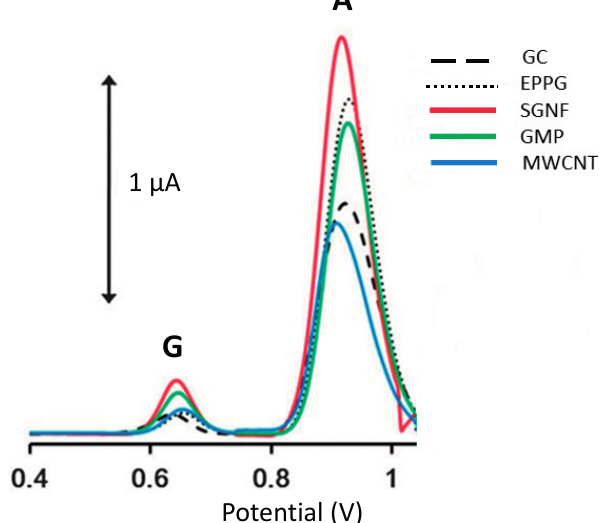
Figure 2. DPV of Gua (G) and Ade (A) on glassy carbon (GC), edge plane pyrolytic graphite (EPPG), stacked graphene nanofibers (SGNF), graphite microparticles (G μ P), and MWCNT electrodes for electrochemical detection. Reproduced from [93] with